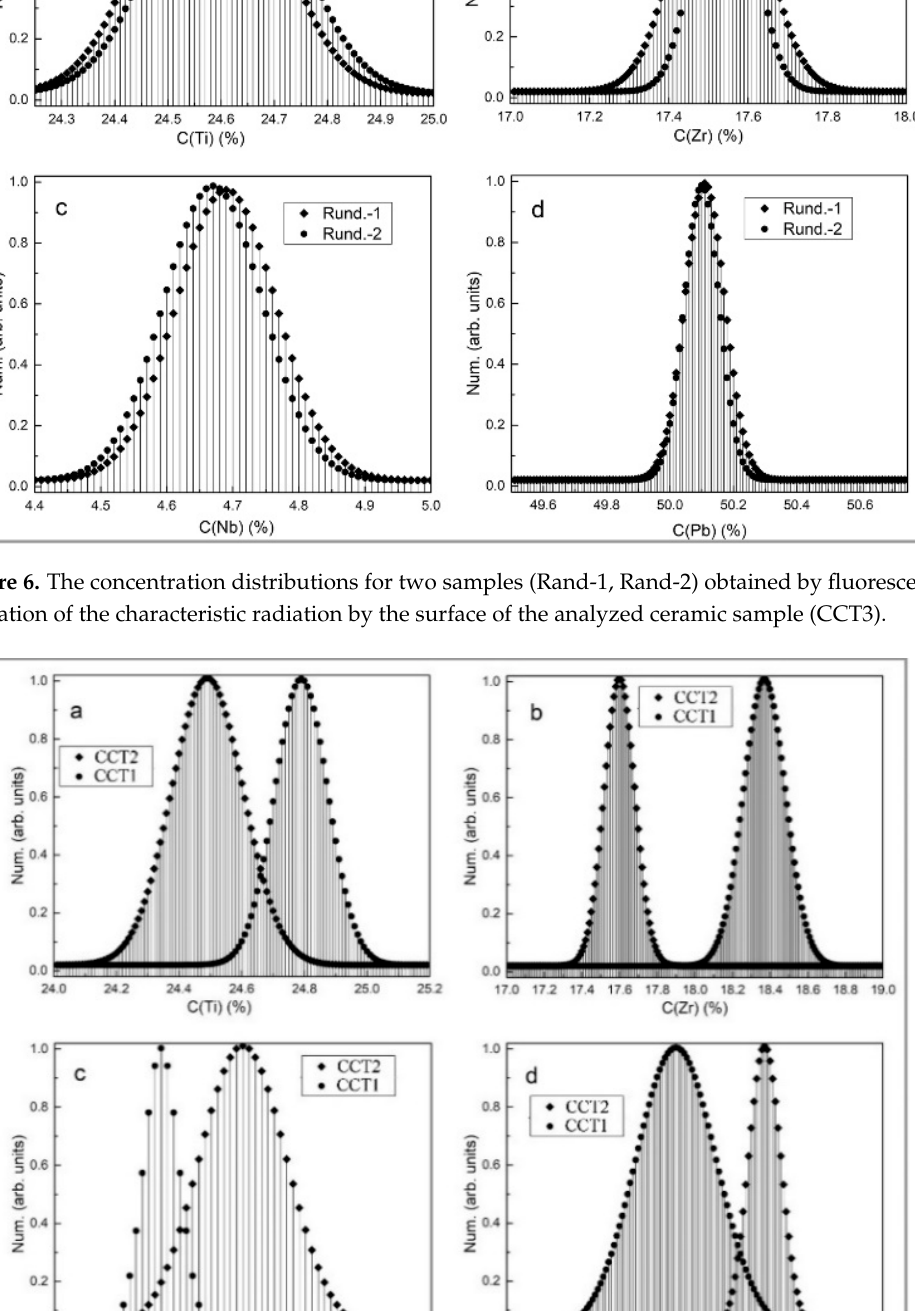
Figure 8. Results of the statistical analysis and the distribution of concentrations of the basic chemical elements obtained for a sample (CCT3) prepared by the standard technology at a stage just before the sintering process.